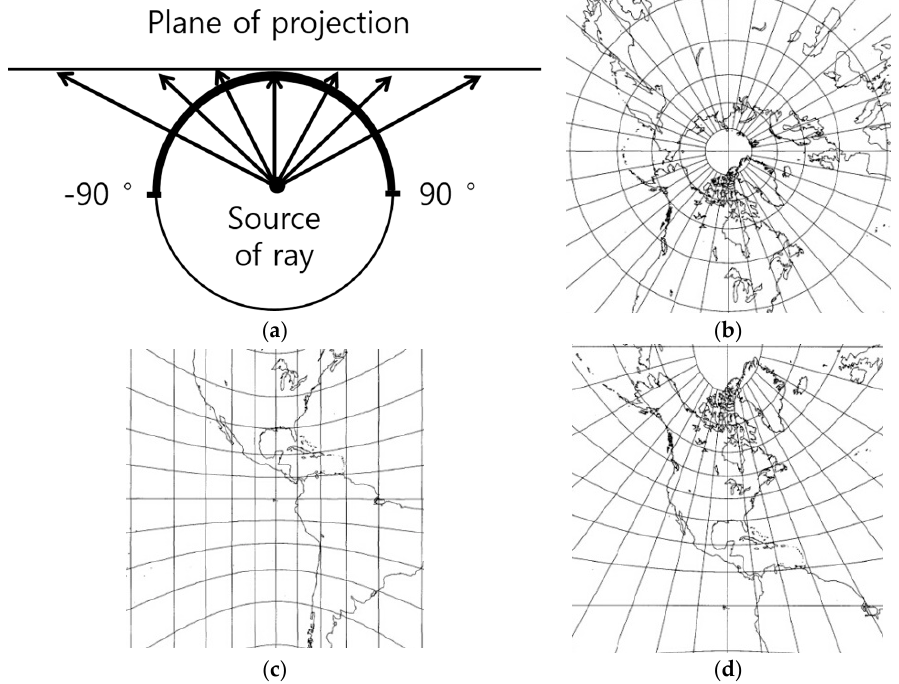
Figure 3. Basic theory of rectilinear projection and three types of projected results. ( a ) Basic theory for rectilinear projection; ( b ) Polar rectilinear projection ; ( c ) Equatorial rectilinear projection; ( d ) Oblique rectilinear projection.